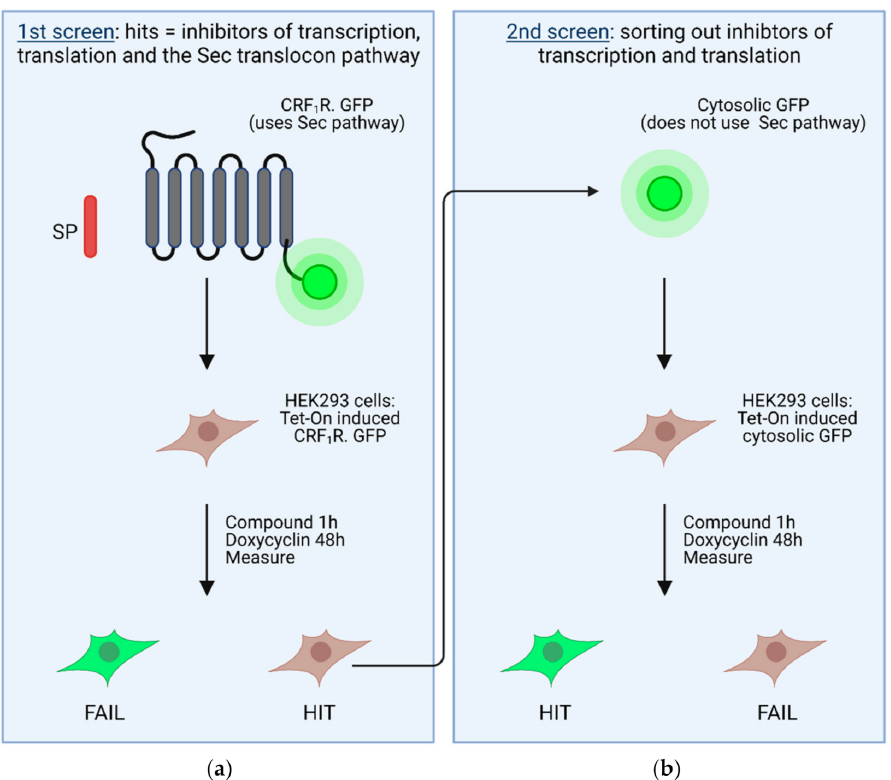
Figure 4. Scheme of the primary and the secondary screen in stably transfected HEK 293 cells. In the primary screen ( a ), Tet-On-controlled CRF1R.GFP was used, a GFP-tagged GPCR possessing a cleavable signal peptide that uses the SRP-Sec61 targeting/translocation pathway. The secondary screen ( b ) was performed with Tet-On-controlled, unfused, soluble GFP, which does not use the SRP-Sec61 targeting/translocation pathway. Hits of the primary screen were used in the secondary screen to deselect inhibitors of the transcription/translation machinery. Figure modified from